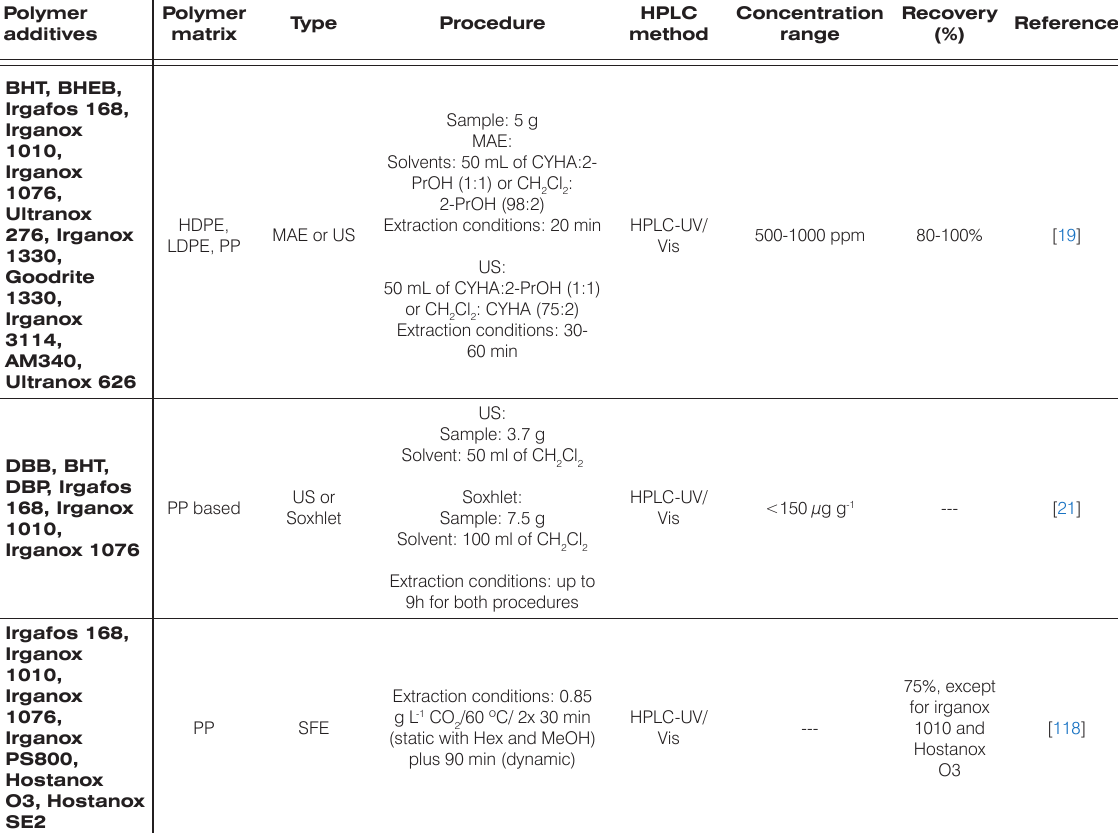
Polymer additives